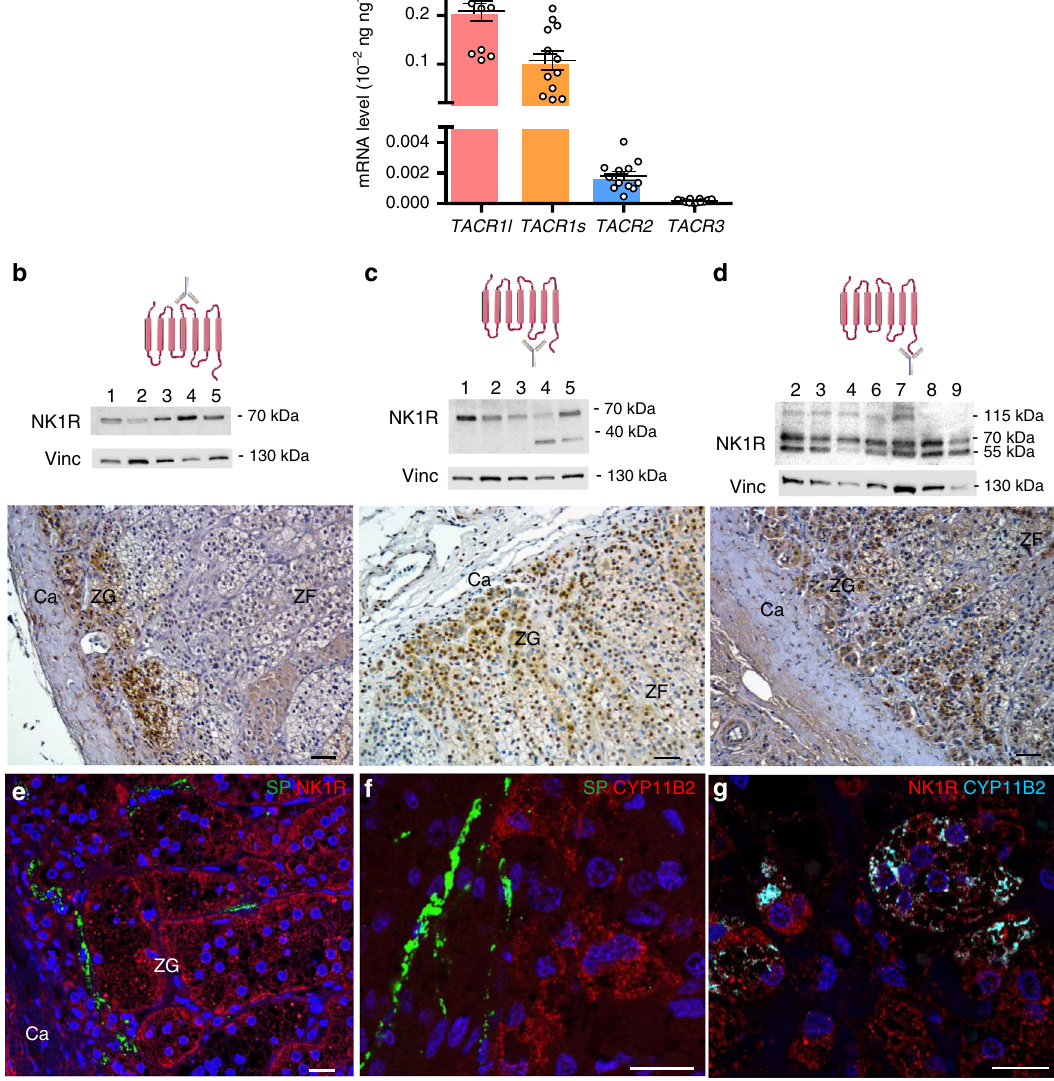
Fig. 2 Expression of tachykinin receptors in the human adrenal gland. a Quantitative RT-PCR analysis of TACR1l , TACR1s , TACR2 and TACR3 mRNAs ( n = 12 independent adrenals). Each dot indicates one adrenal. Data are presented as mean ± SEM. CI 95%: 0.16 – 0.25, 0.06 – 0.15, 0.001 – 0.002 and 0.0001 – 0.0002 for TACR1l , TACR1s , TACR2 and TACR3 , respectively. Statistical analysis was determined by Kruskal – Wallis test and Dunn ’ s post-test after one-way ANOVA. Signi fi cance denoted by *** p < 0.001. b – d Presence of neurokinin type 1 receptor (NK1R) visualised by western blot and immunohistochemistry by using three antibodies recognising different epitopes (diagrams on the higher panels). Representative western blots showing bands of different molecular weights detected in adrenal extracts (middle panels; n = 5 adrenals in b and c ; n = 7 adrenals in d ). Vinculin (Vinc) was used as a loading control. Distribution of NK1R immunostaining in the cortex (lower panels; scale bars = 50 µ m; Ca capsule, ZG zona glomerulosa, ZF zona fasciculata, microphotographs representative of n = 10, 7 and 10 adrenals in b – d , respectively). Schemas created using medical diagrams available from https://smart.servier.com under a CC BY 3.0 licence (https://creativecommons.org/licenses/by/3.0/). e – g Immuno fl uorescence detection of SP ( e , f ) and NK1R ( e , g ) or CYP11B2 (aldosterone synthase; f , g ) in the ZG (scale bars = 20 µ m; microphotographs representative of n = 4